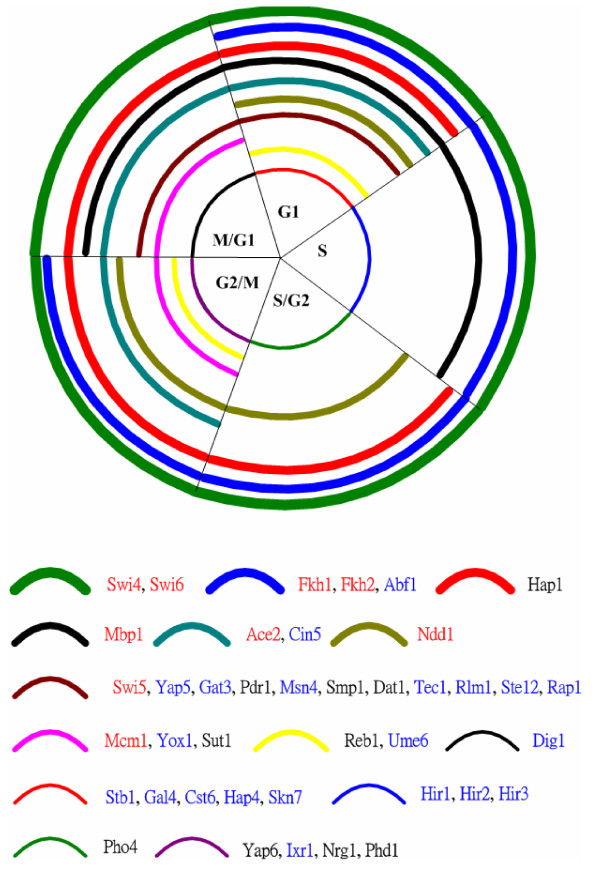
The cell cycle phases in which each of the 40 identified TFs carries out its regulatory function. Nine well-known cell cycle TFs are colored red and another 21 TFs that are also involved in the cell cycle [23-25] are colored blue.